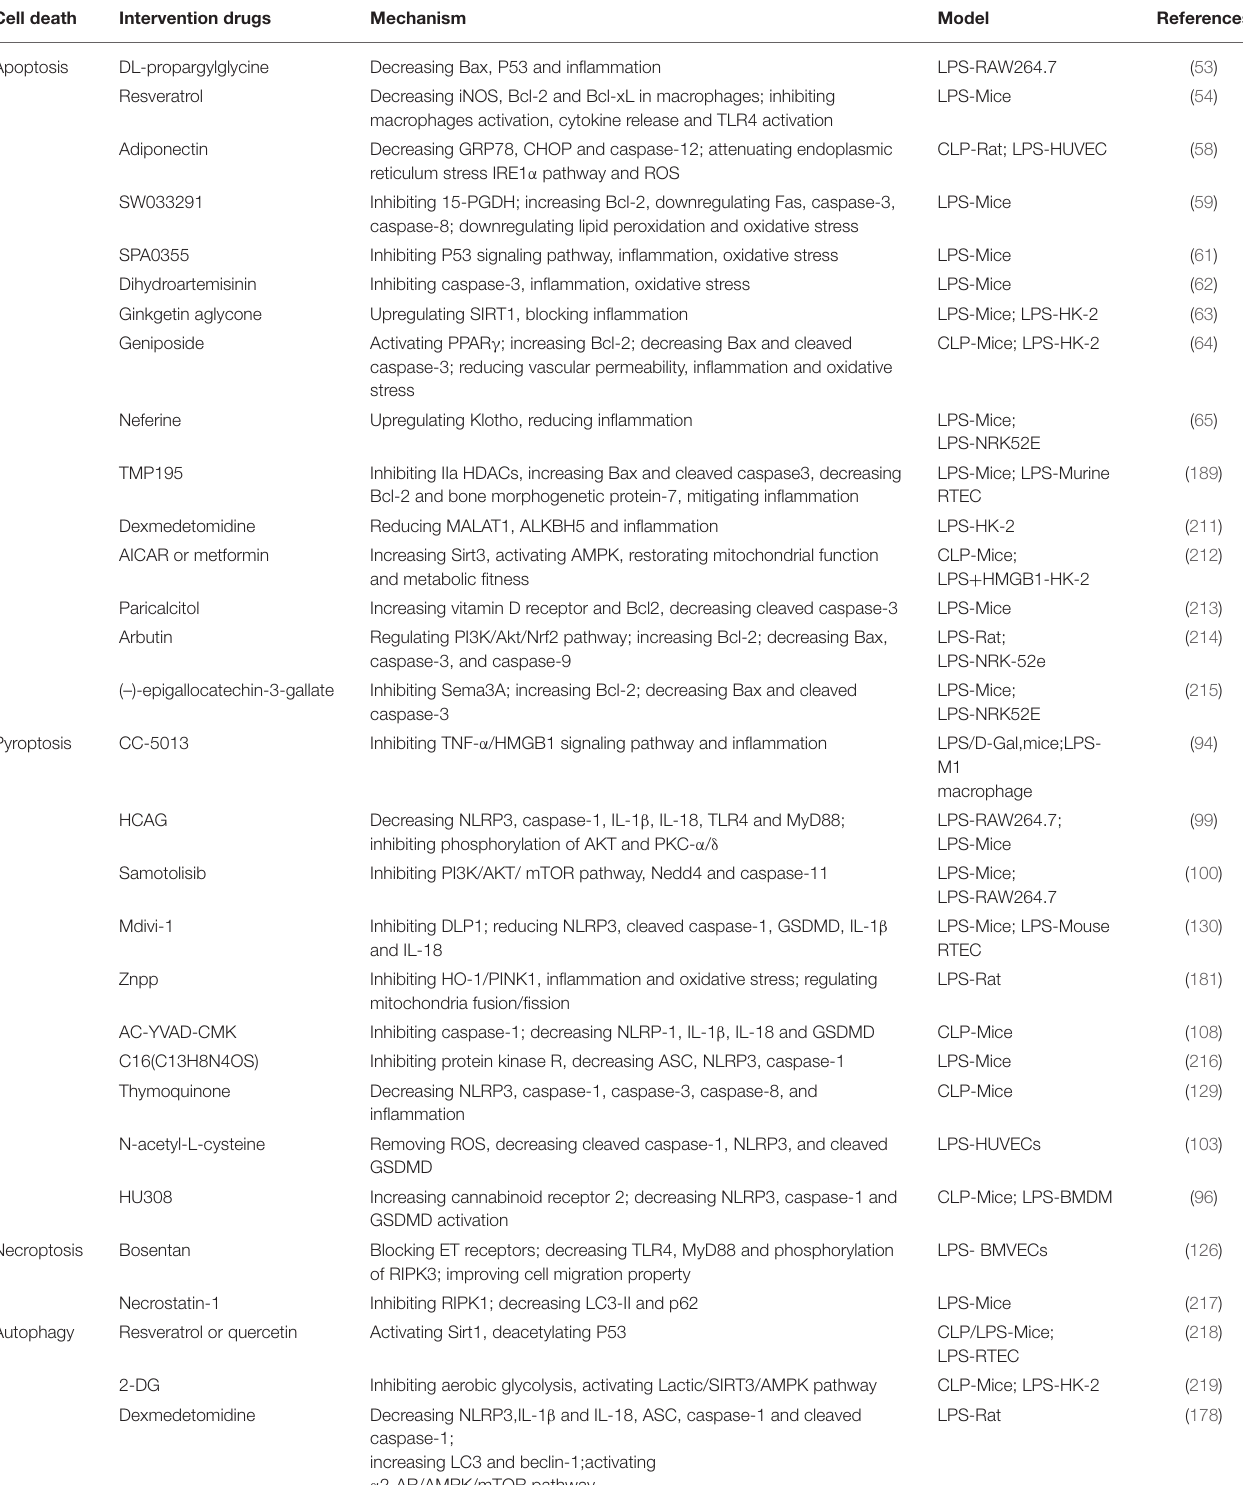
TABLE 1 | The intervention drugs of programmed cell death in sepsis-AKI. Cell